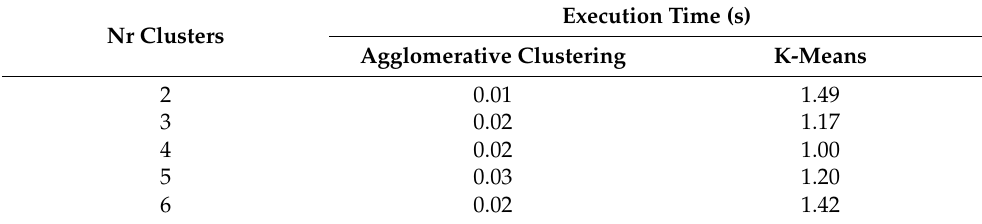
Table 6. Number of clusters and clustering execution time variation.